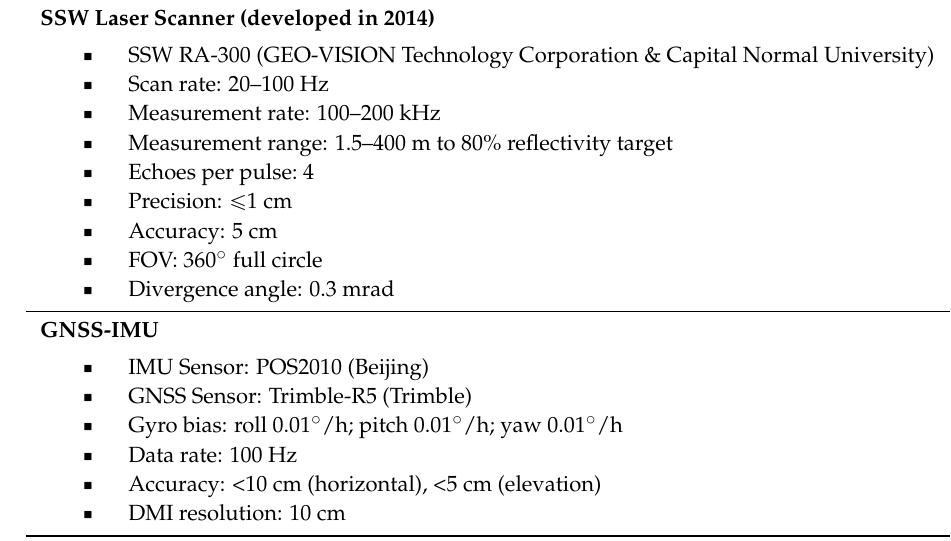
Table 1. A SSW laser system equipment and characteristics.